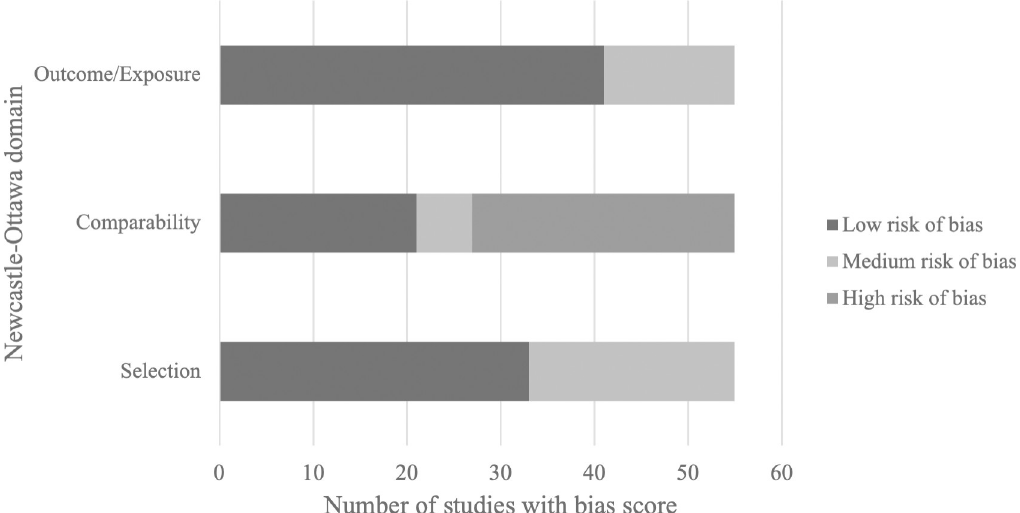
Fig 2. Quality of the studies included in the systematic review for study selection, comparability, and ascertainment of outcome.